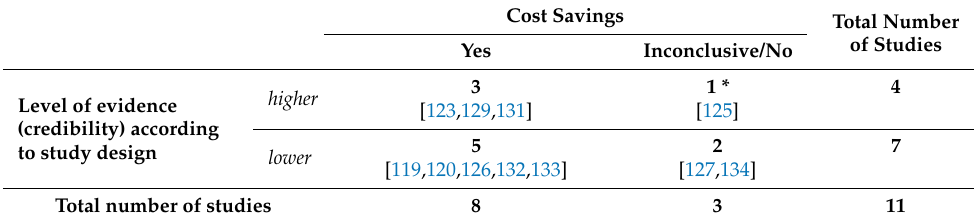
Cost Savings Total Number